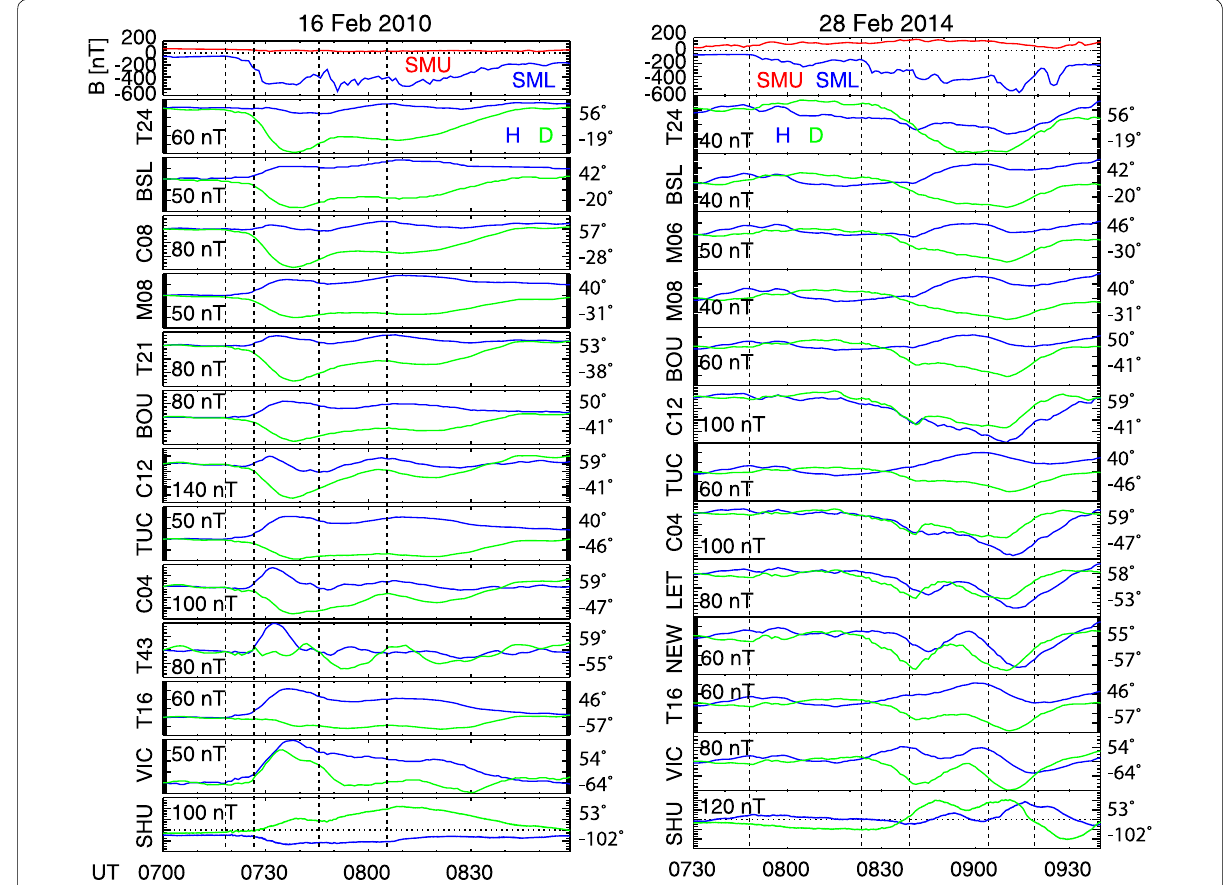
Fig. 2 The top panels are the SMU / SML indices for the 16 February 2010 and 28 February 2014 events. The other panels show the H (blue) and D (green) components of mid-latitude magnetometer data, sorted by magnetic longitude. The magnetic latitude and longitude are indicated to the right of each panel. The y -scale for each panel is indicated in units of